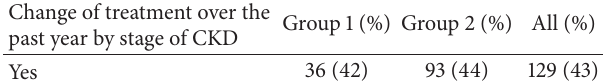
Table 4: Change of treatment over the past year by stage of CKD among all included patients.